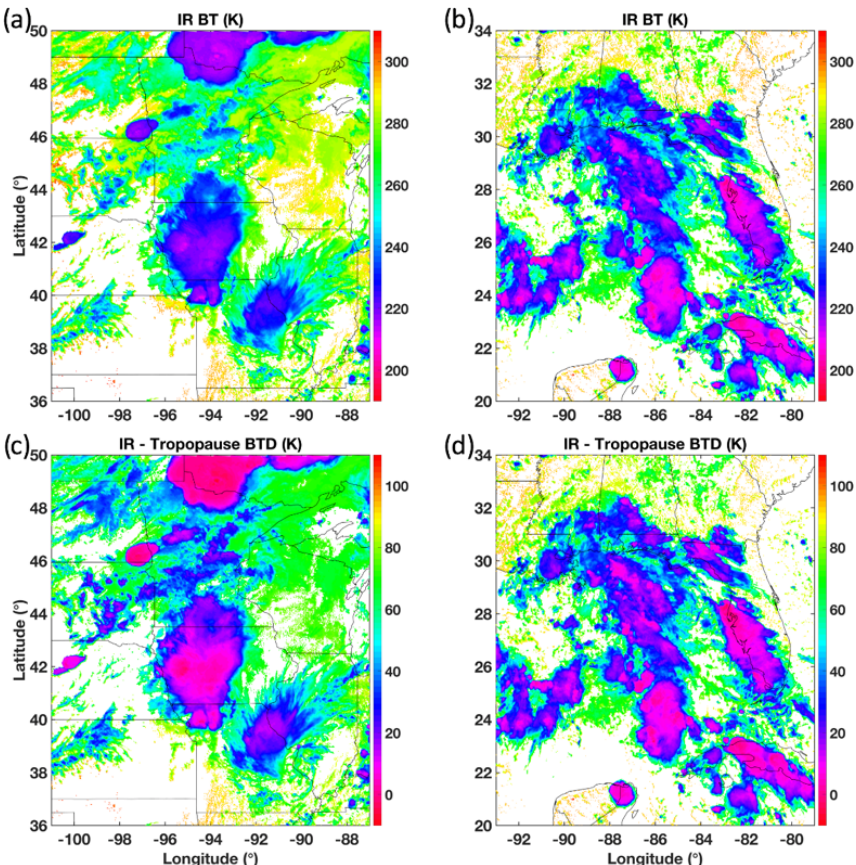
Figure 2. Severe wind- and hail-producing storms (as reported by NOAA) on 31 August 2018 at 20:47UTC visualized by GOES-16 (a) IR BT at northern CONUS latitudes, (b) IR BT at southern CONUS latitudes, (c) IR − Trop BTD at northern CONUS latitudes, and (d) IR − Trop BTD at southern CONUS latitudes. Without tropopause normalization, the relative intensity of the northern storms appears less than that of the southern storms despite both being significant producers of severe